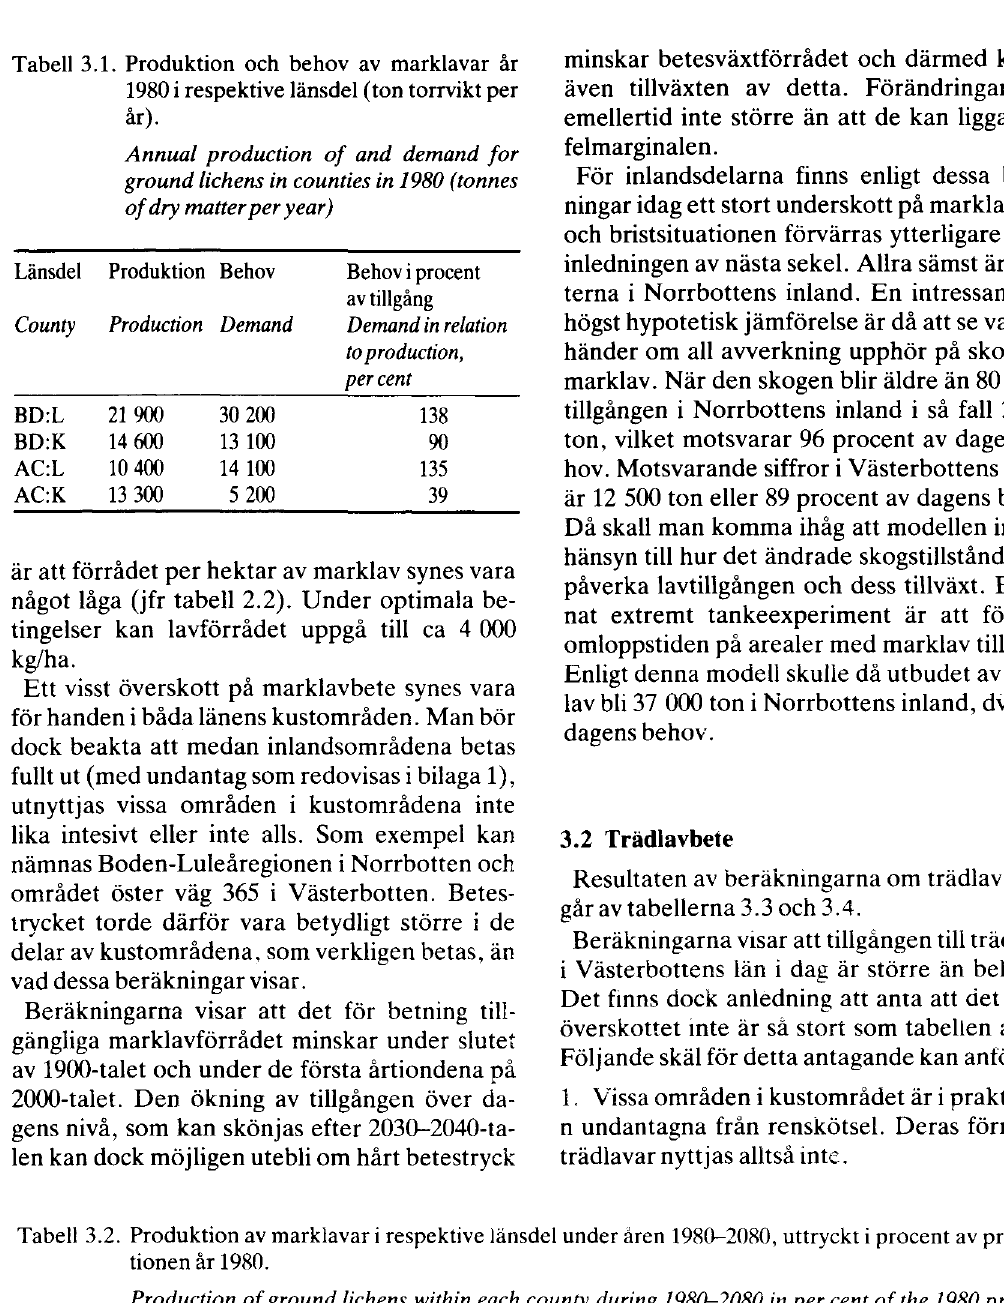
Tabell 3.2. Produktion av marklavar i respektive lånsdel under åren 1980-2080, uttryckt i procent av produk tionen år